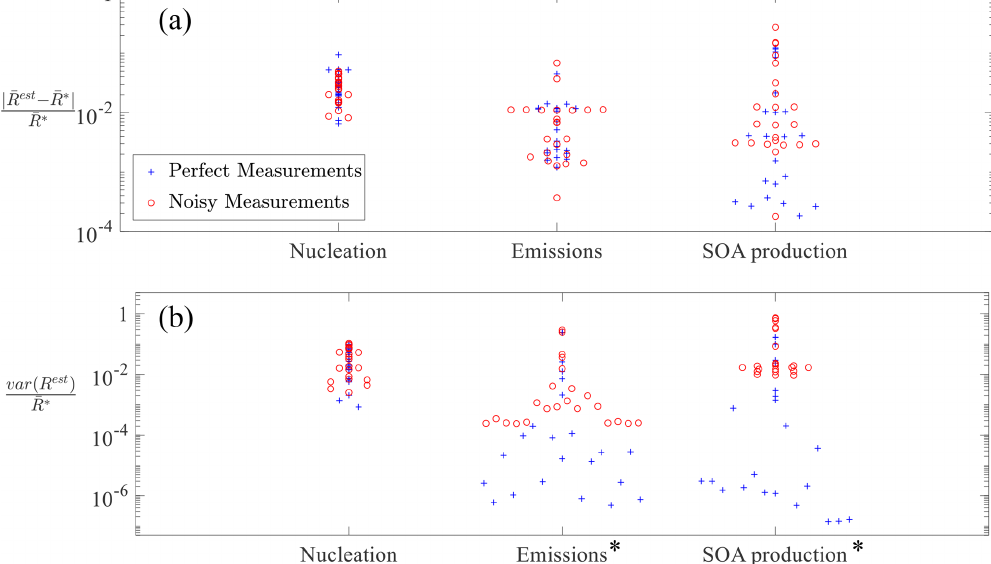
Figure 7. Beeswarm plots showing (a) normalized mean error and (b) normalized variance in estimated nucleation, emissions, and SOA production rates ( R est ) relative to the actual process rates ( R ∗ ). The blue crosses show the 23 scenarios with perfect measurements, and the red circles show the same 23 scenarios with noisy measurements. ∗ The difference between the perfect and noisy measurement scenarios is statistically significant for α = 0 .